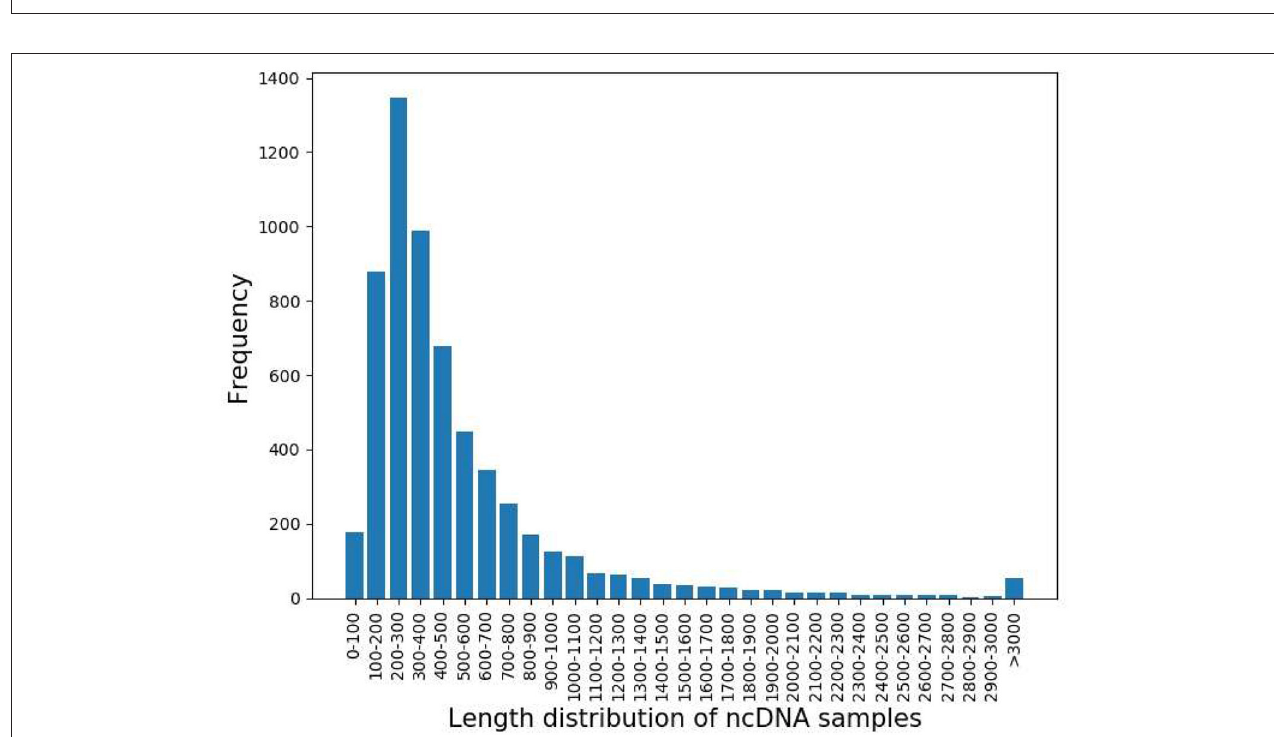
FIGURE 2 | The length distribution of ncDNA